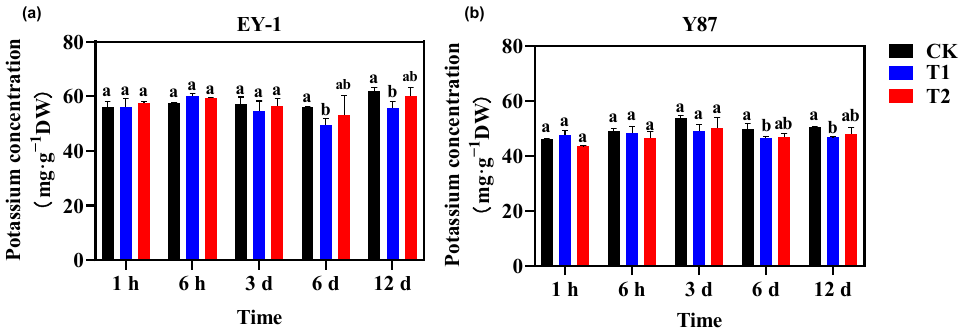
Figure 1. Changes of K + concentration in shoots of EY-1 ( a ) and Y87 ( b ) at 1 h, 6 h, 3 d, 6 d, and 12 d after topping. CK: control, T1: topping, T2: IAA application after topping. Each value represents the mean of three biological replicates ± SD value. Different letters indicate significant difference among treatments at p < 0.05.